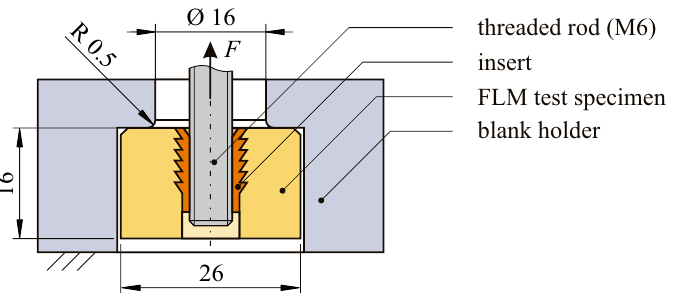
Figure 5. Schematic illustration of the pull-out test setup (all dimensions in